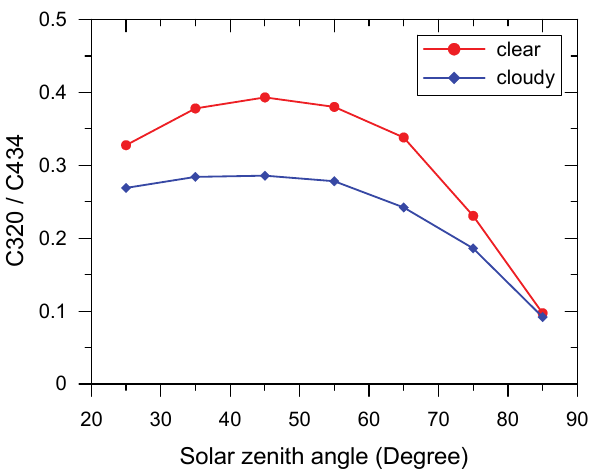
Fig. 12. Measured intensity ratio for wavelength of 320nm (C320) and 434nm (C434) as a function of solar zenith angle under clear and cloudy conditions, averaged over the period of August 2008 to September 2011.